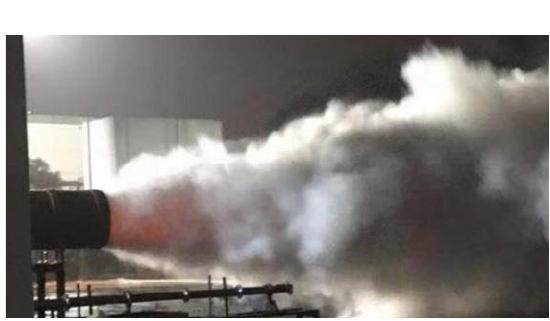
Figure 14. Direct-connected ground test of a ducted rocket